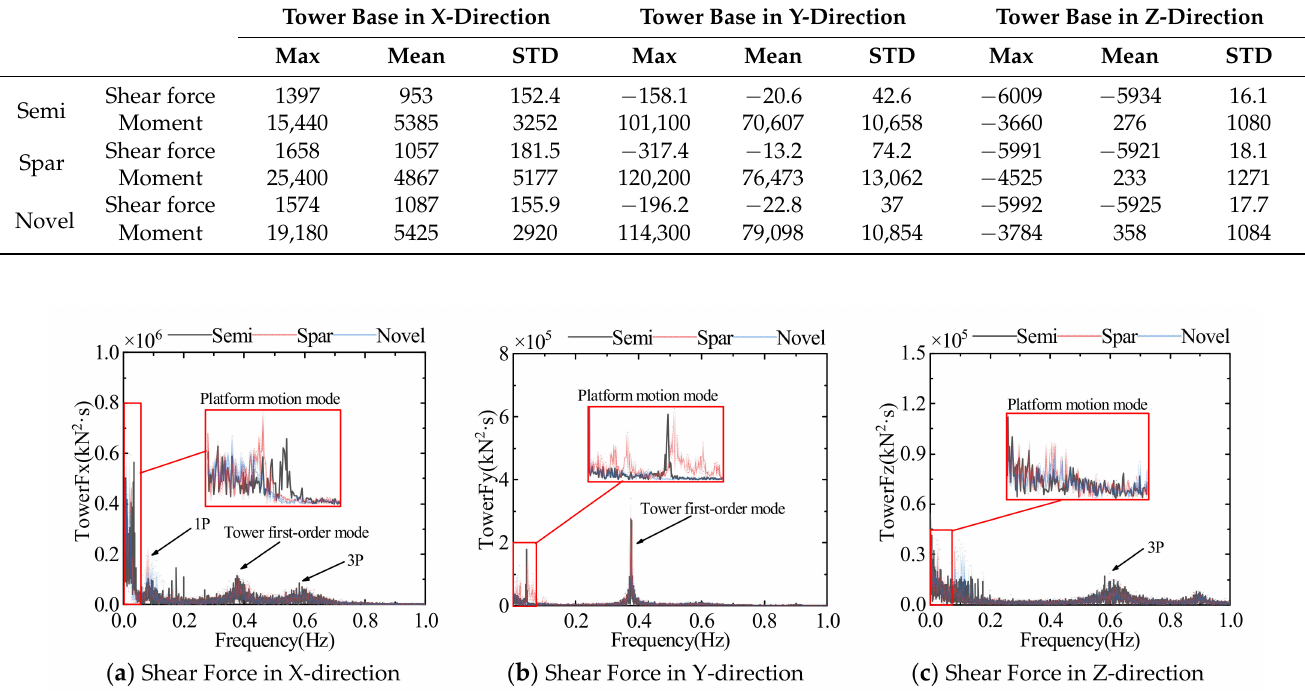
Figure 31. Power spectral density of tower base shear force of three